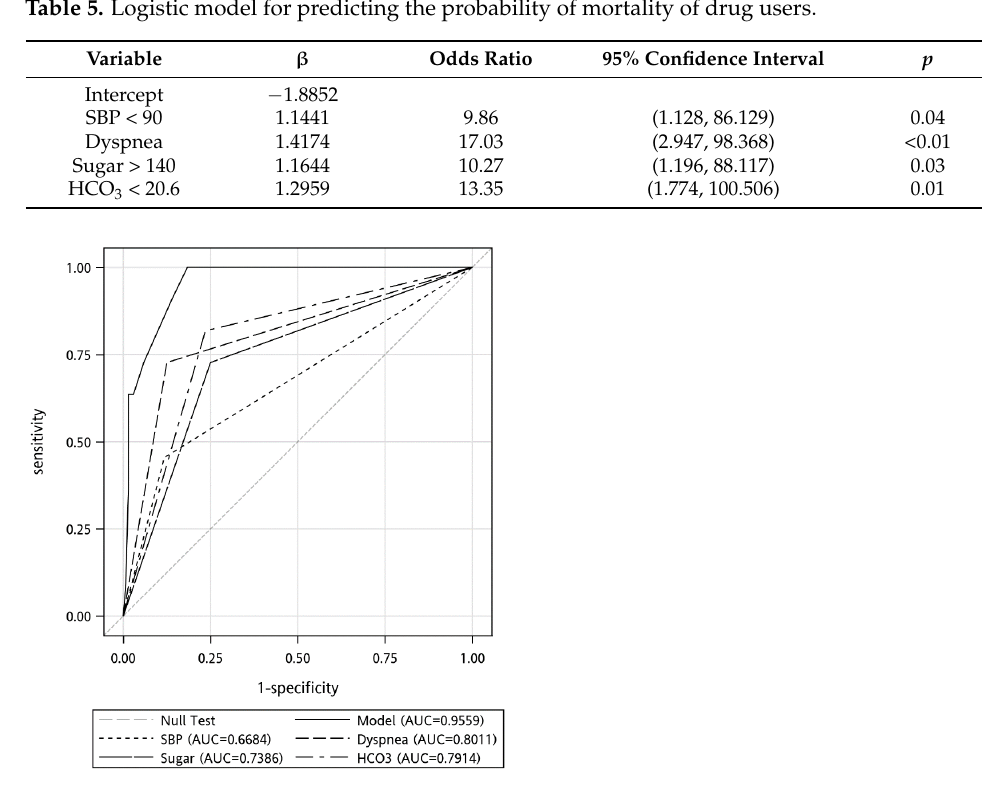
Figure 1. Receiver operating characteristic (ROC) curves for the prediction of the in-hospital mor- tality.